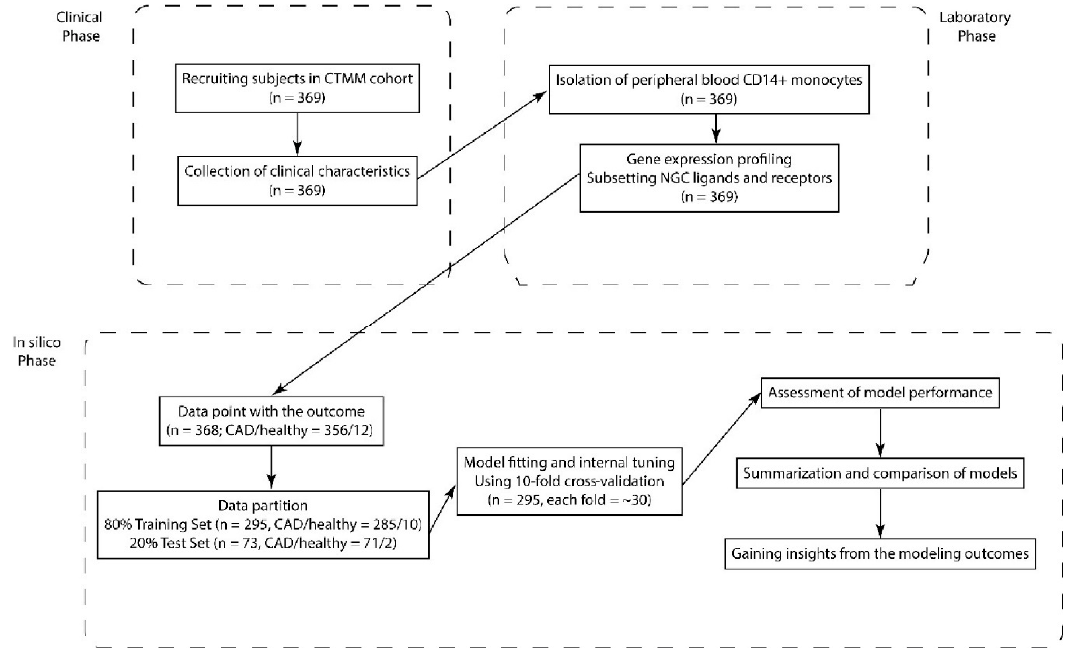
Figure 1. Flowchart of predictive modeling using neuroimmune guidance cues (NGCs). Subjects in the CIRCULATING CELLS cohort were recruited based on inclusion criteria. The clinical characteristics were collected, peripheral blooded CD14-positive monocytes were isolated and their transcriptomes were profiled. The expression of NGCs was subset. The individuals were randomly assigned to the Training Set or Test Set for external assessment of the model performance. Classification models that were built on the Training Set data and model performance were internally assessed with cross-validation. Finally, we made comparisons between the models and gained insights on the choice of model and Table 1. Clinical characteristics of the CIRCULATING CELLS cohort.